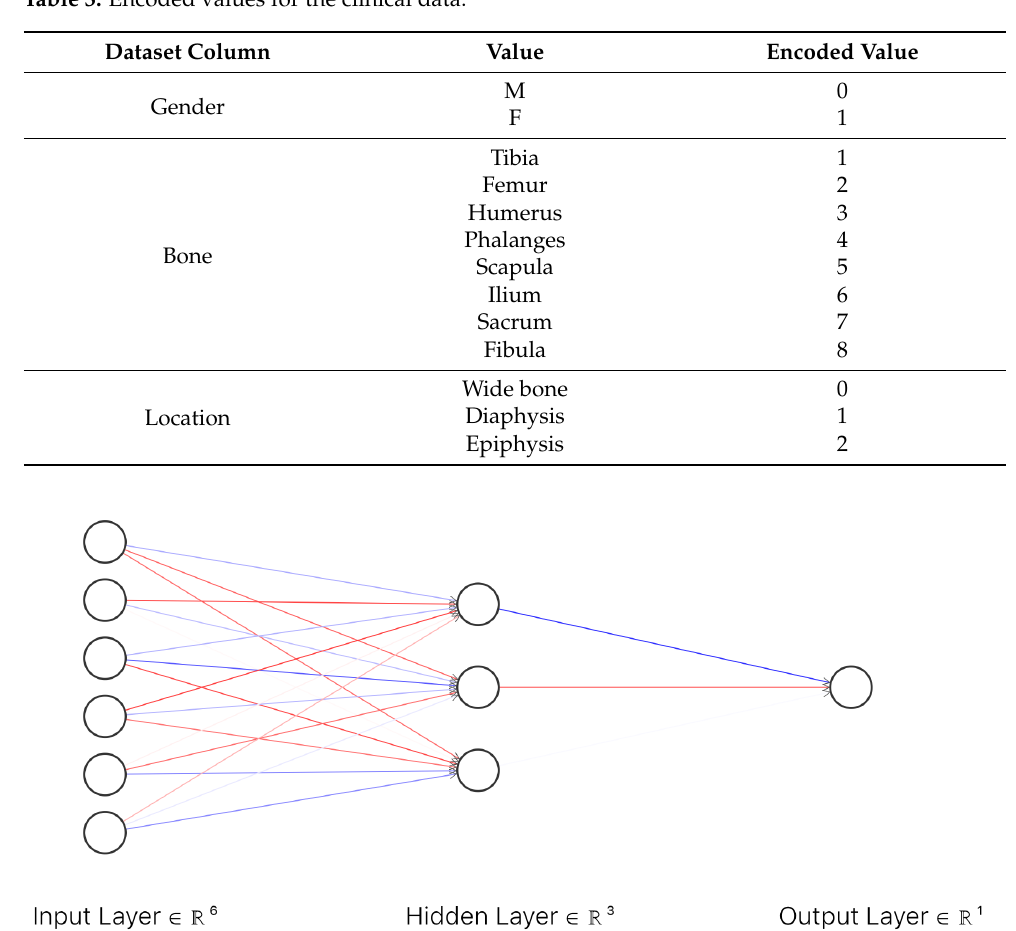
Figure 5. Architecture of the artificial neural network for the clinical model.